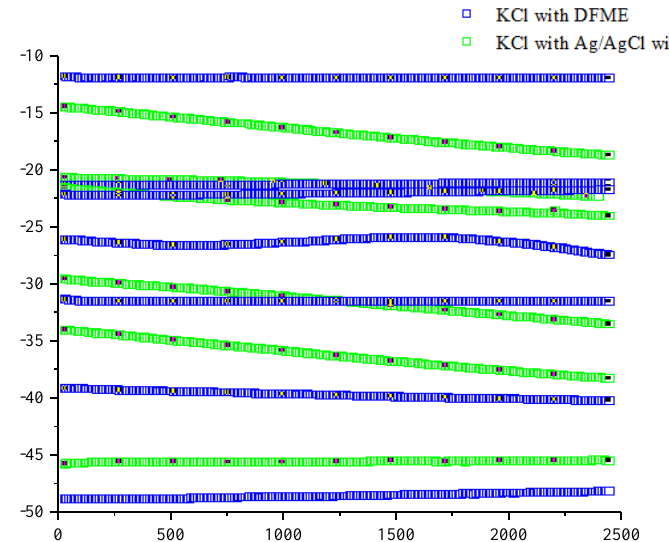
Figure 7. Open circuit potential (OCP) for different concentrations of KCl using comparison measure- ments between the traditional Ag/AgCl and the DES fabricated micro-reference electrode (DFME) at room temperature.